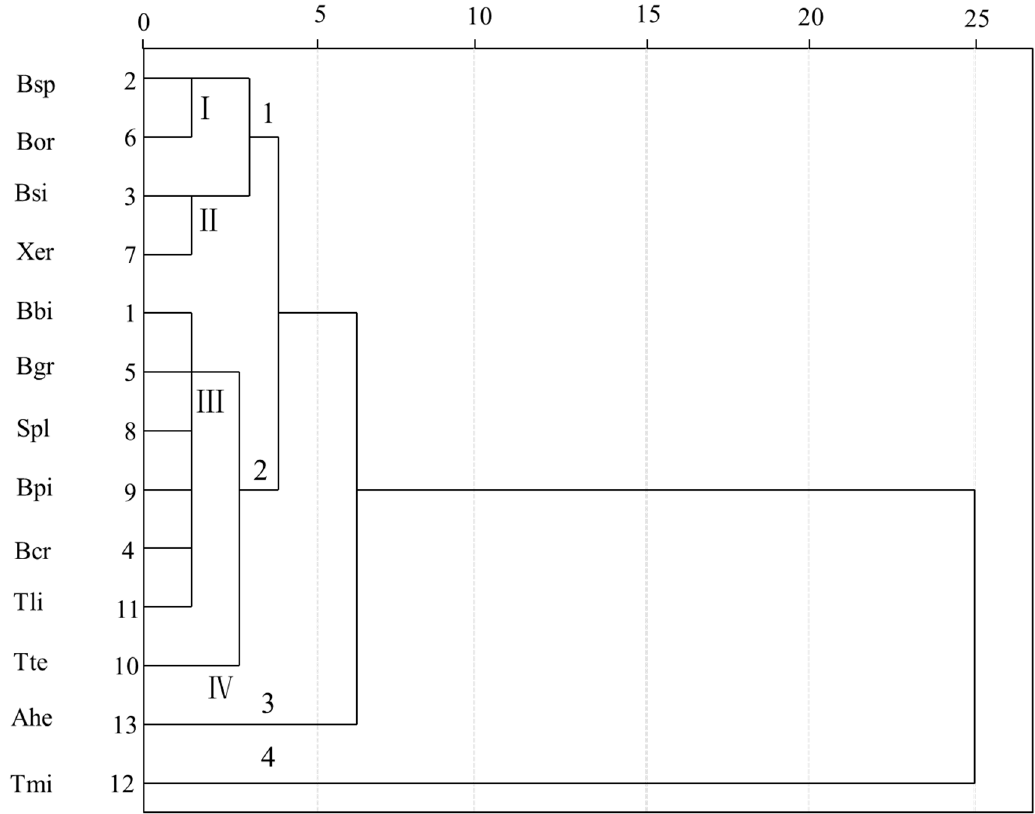
Figure3. Tree diagram of the cluster analysis for the 13 mushroom species. Figure 3. Tree diagram of the cluster analysis for the 13 mushroom